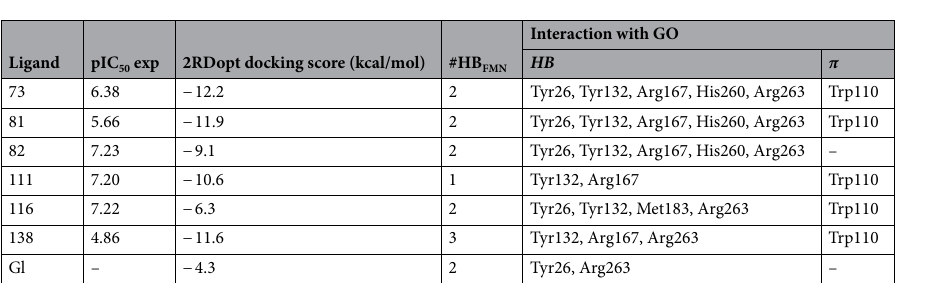
Table 2. Modelling and docking results obtained for the studied compounds.